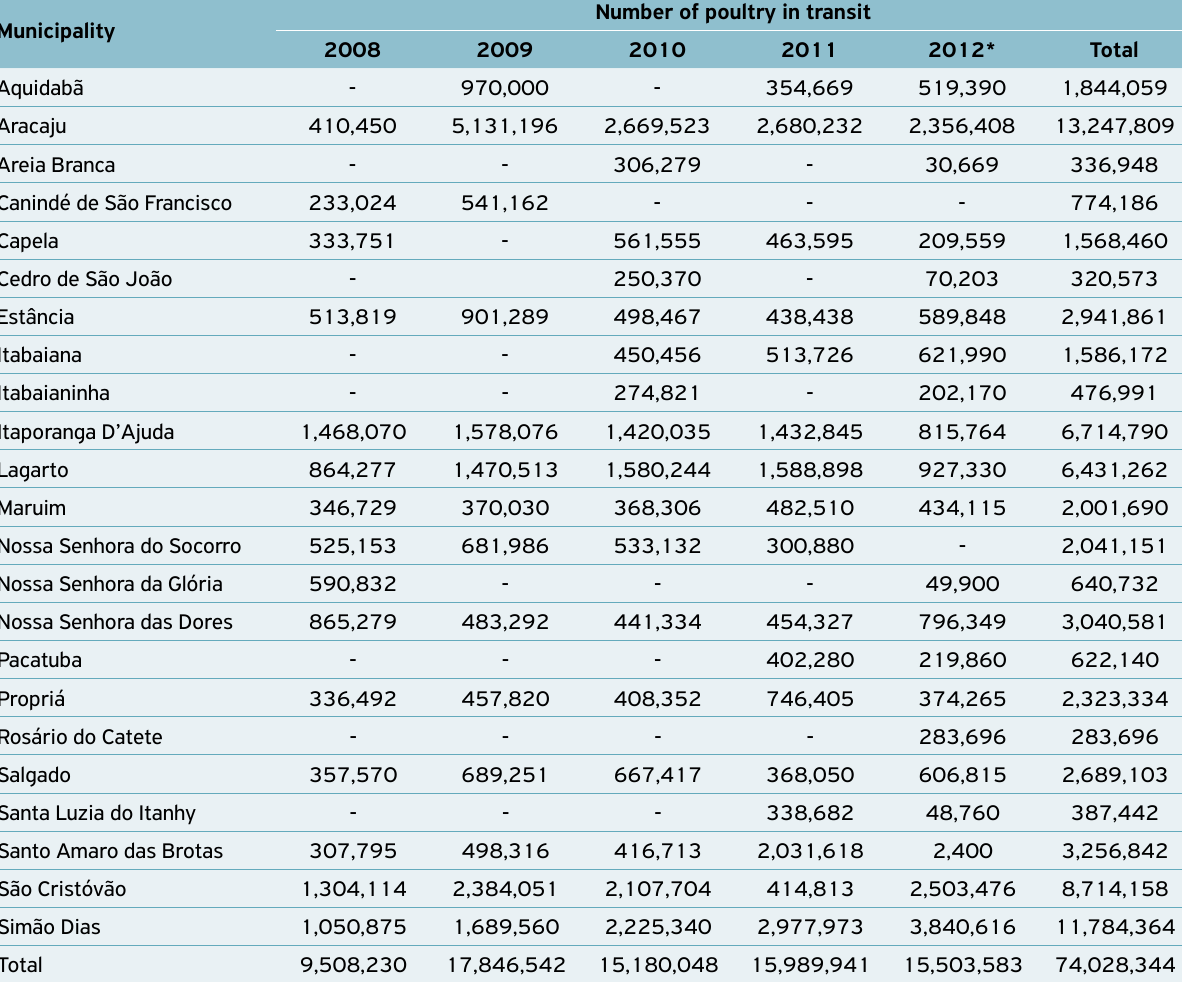
Table 4. Poultry transit in the municipalities of the state of Sergipe, Brazil, 2008–2012. Municipality